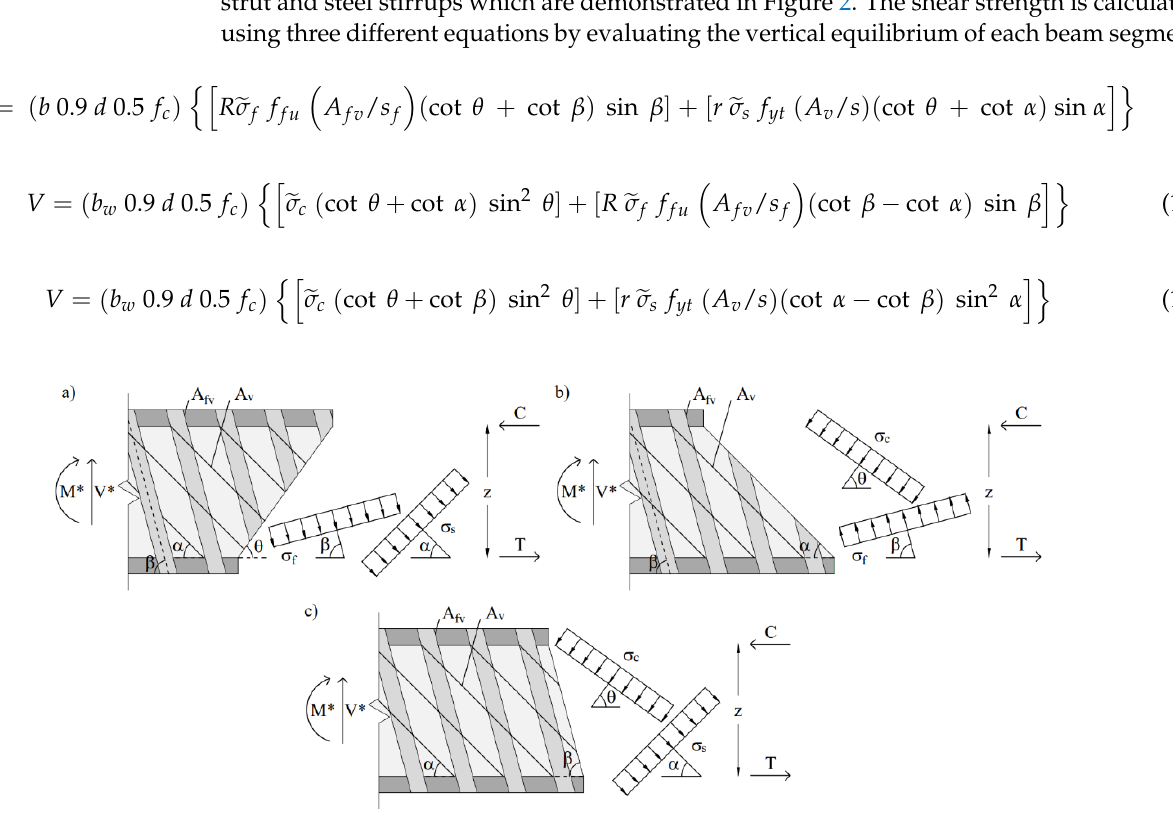
Figure 2. Beam segments identified via three sections parallel to stress field directions of ( a ) concrete strut; ( b ) steel stirrups; ( c ) FRP reinforcement. M* and V* represent the moment and shear acting on the considered section.